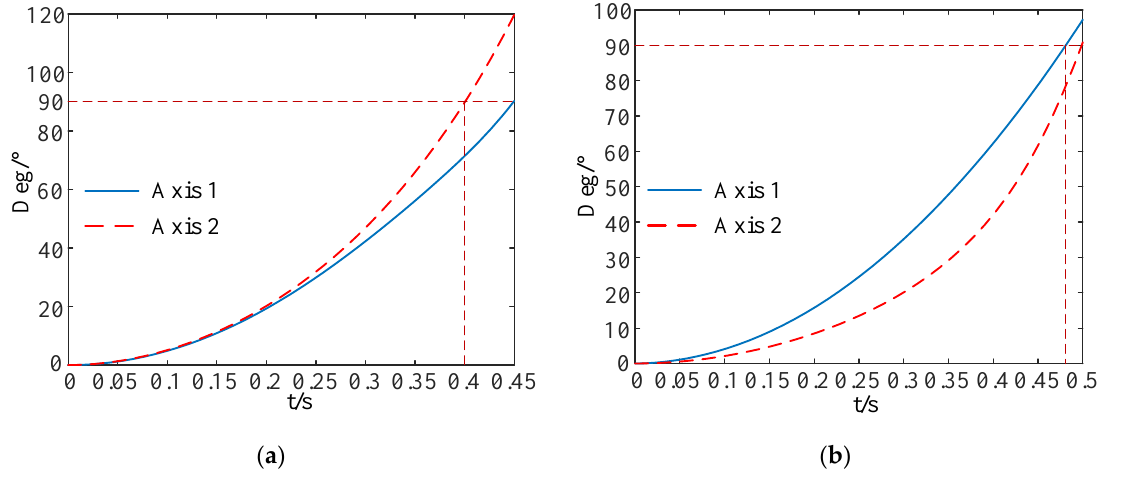
Figure 26. Axis 1 and axis 2 deployment angle and deployment time curve: ( a ) synchronous deploy- ment mode; ( b ) non-fixed-axis – fixed-axis stepwise deployment mode.